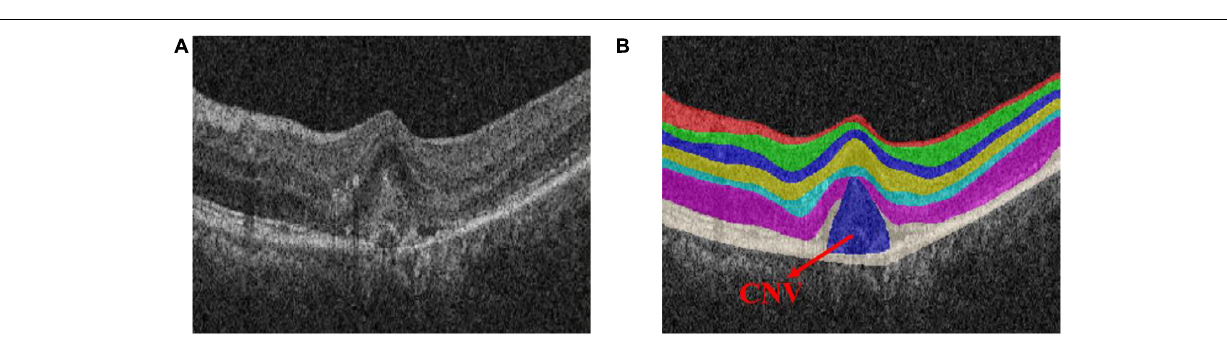
FIGURE 2 | Optical coherence tomography (OCT) image of the normal retinal layer containing choroid neovascularization (CNV). (A) Original image. (B)